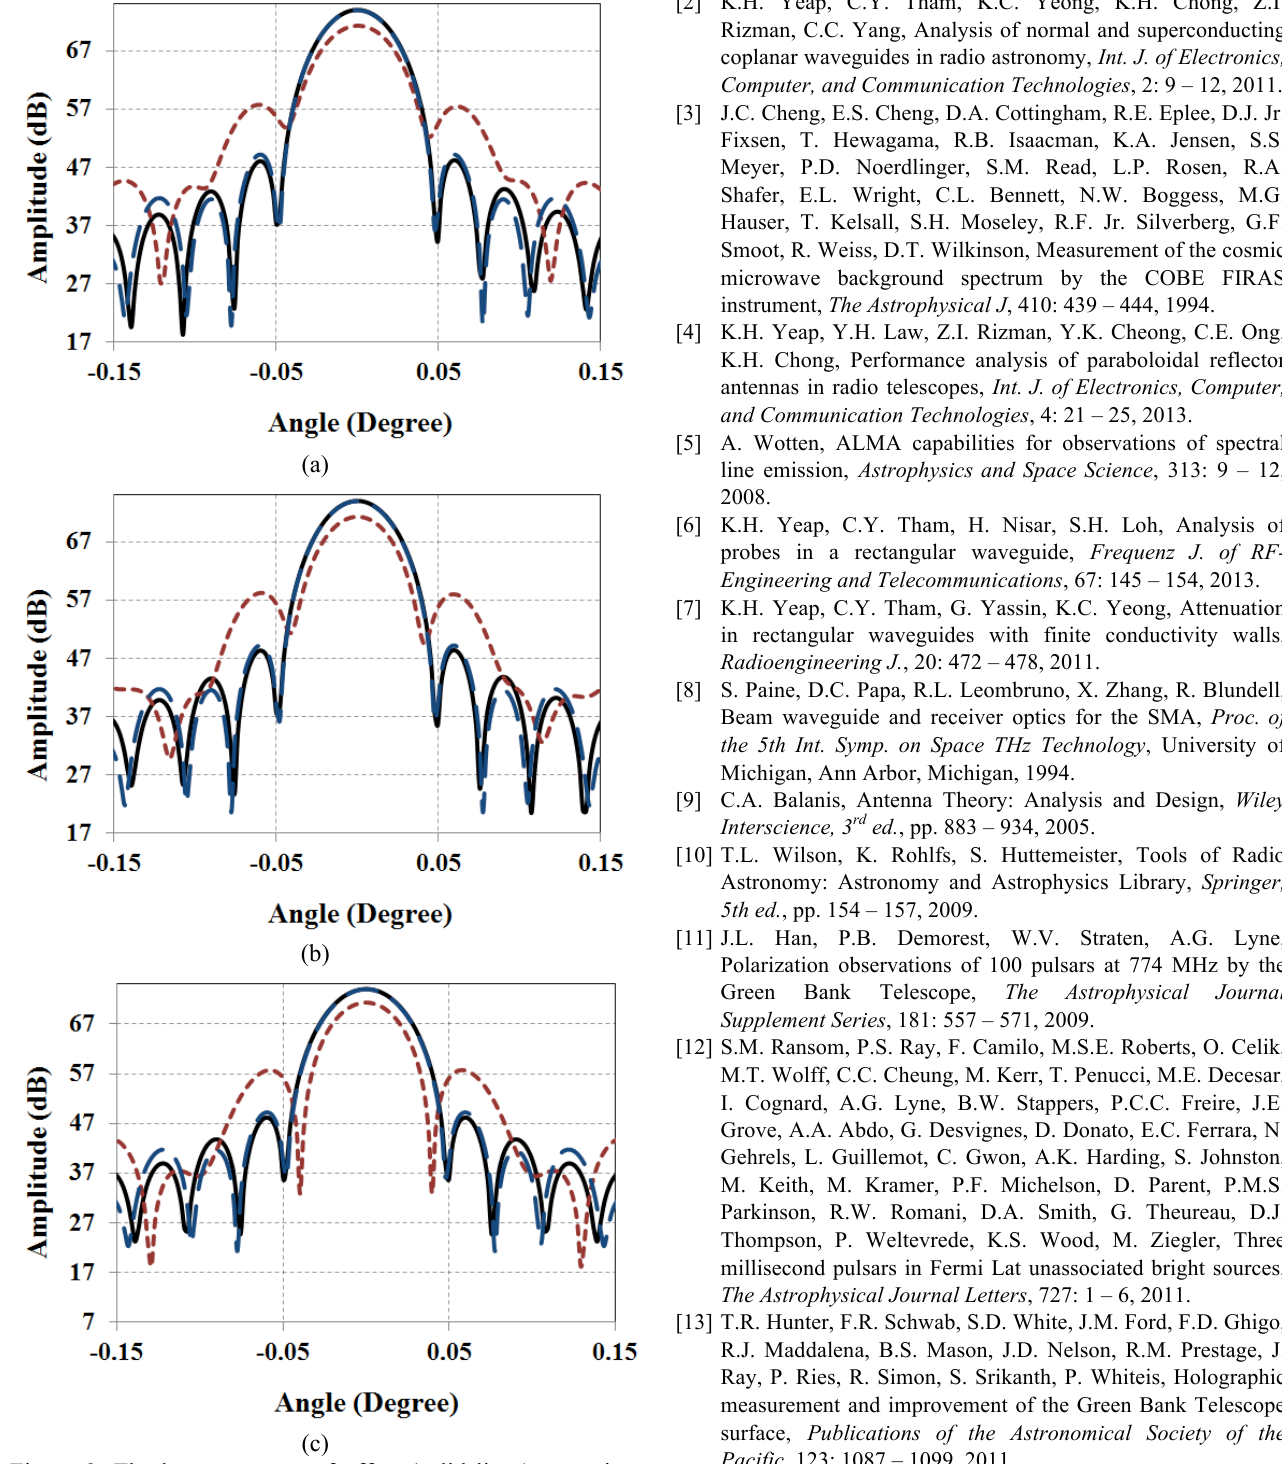
Figure 8: The beam patterns of offset (solid lines), on-axis (dashed lines) and off-axis (dotted lines) Gregorian antenna, at f = 45 GHz and φ = (a) 0º, (b) 45º and (c)